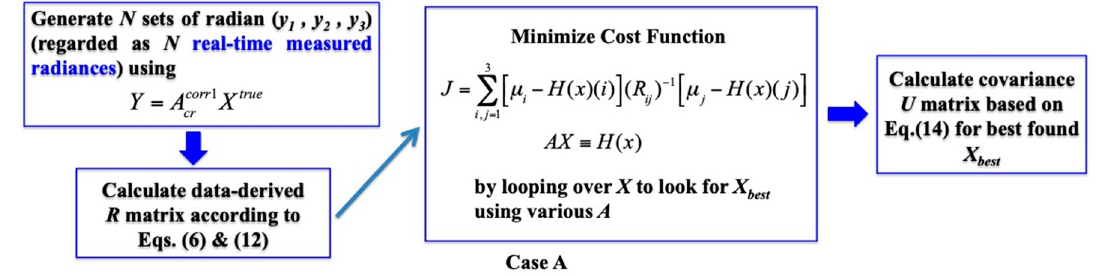
Figure 5. Analysis procedures for Cases A.